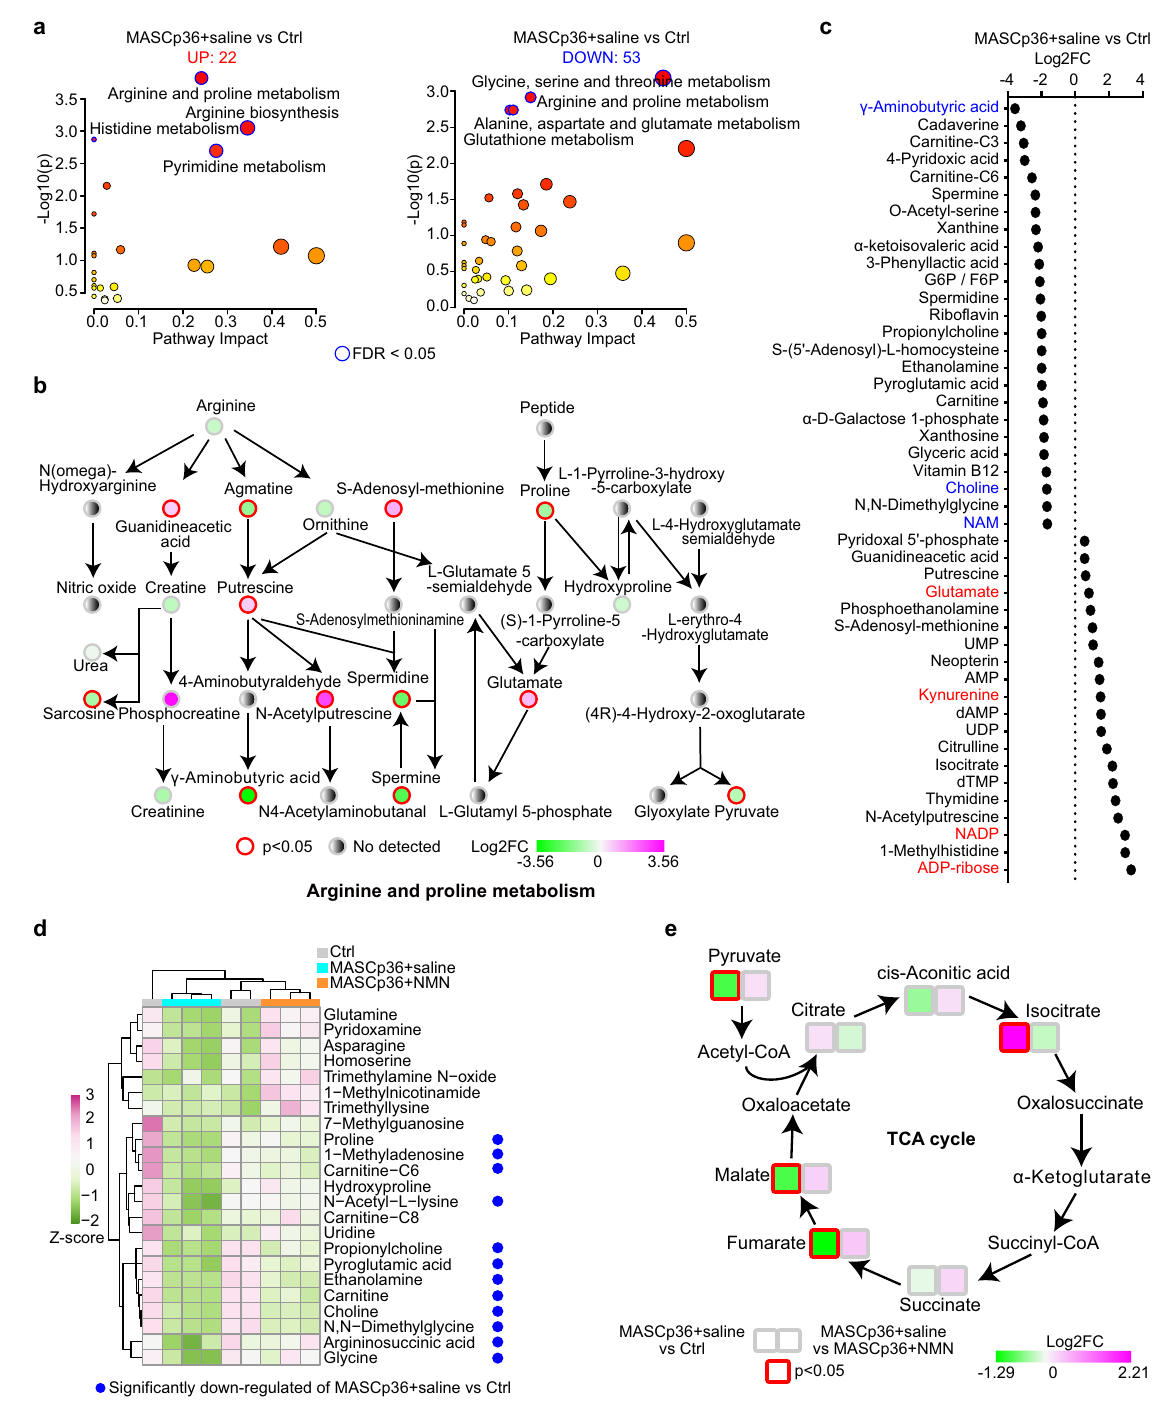
Fig. 7 Metabolomics analysis of MASCp36-infected aged mouse lungs. a KEGG analysis of signi fi cantly differential metabolites ( P < 0.05; FC < 0.8 or FC > 1.25) between the lungs of saline group of MASCp36-infected mice and control mice. b Schematic diagram depicting the dysregulation of arginine and proline metabolism pathways in response to MASCp36 infection. c Dot plot shows the top 25 most upregulated and top 20 most downregulated metabolites. d Heatmap shows relative abundance of signi fi cantly differential metabolites in the NMN group compared with saline group of MASCp36- infected mice. The blue dots mean that the metabolite was signi fi cantly downregulated in saline group of MASCp36-infected mice compared with control mice. e Schematic diagram depicting that dysregulation of metabolites belonging to TCA cycle in MASCp36-infected mice was partially rescued by NMN supplementation. Nodes without color-block represent metabolites which were not